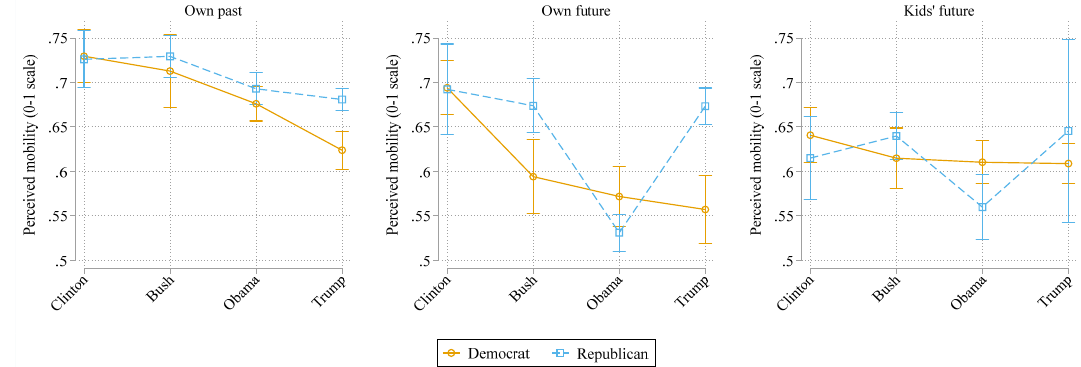
Figure 4. Perceived mobility among White respondents, by presidential administration and most recent presidential vote. Confidence intervals are at the 95% level. Predictive margins are based on models in Table. 3. Table 3. Models predicting perceived mobility among White respondents only.